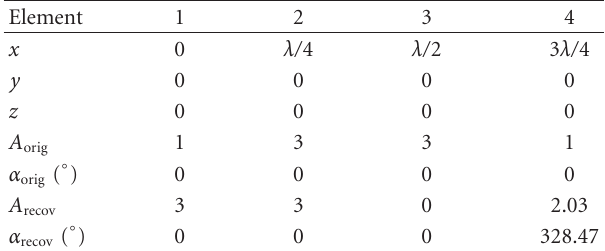
Table 1: A 4-element array parameters before and after